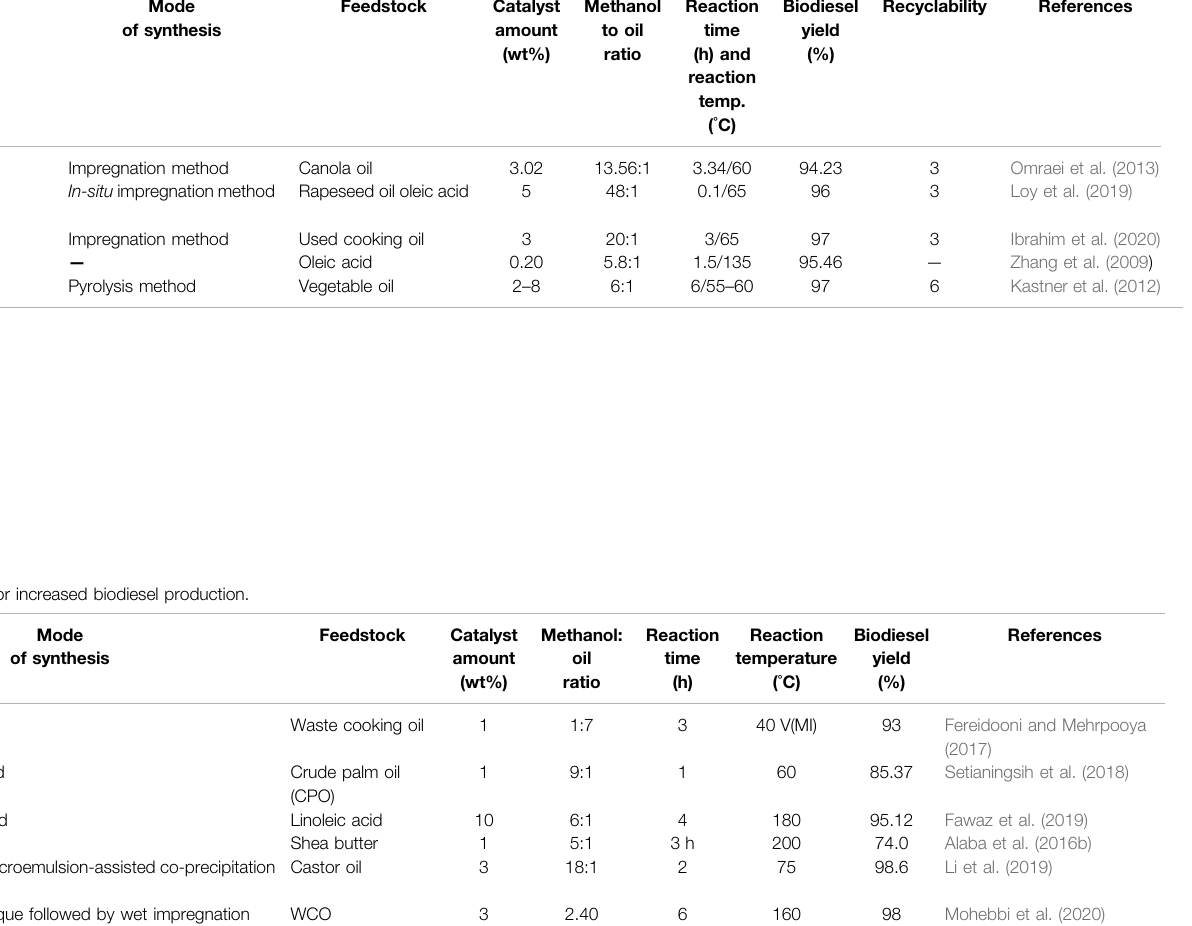
Microwave irradiation